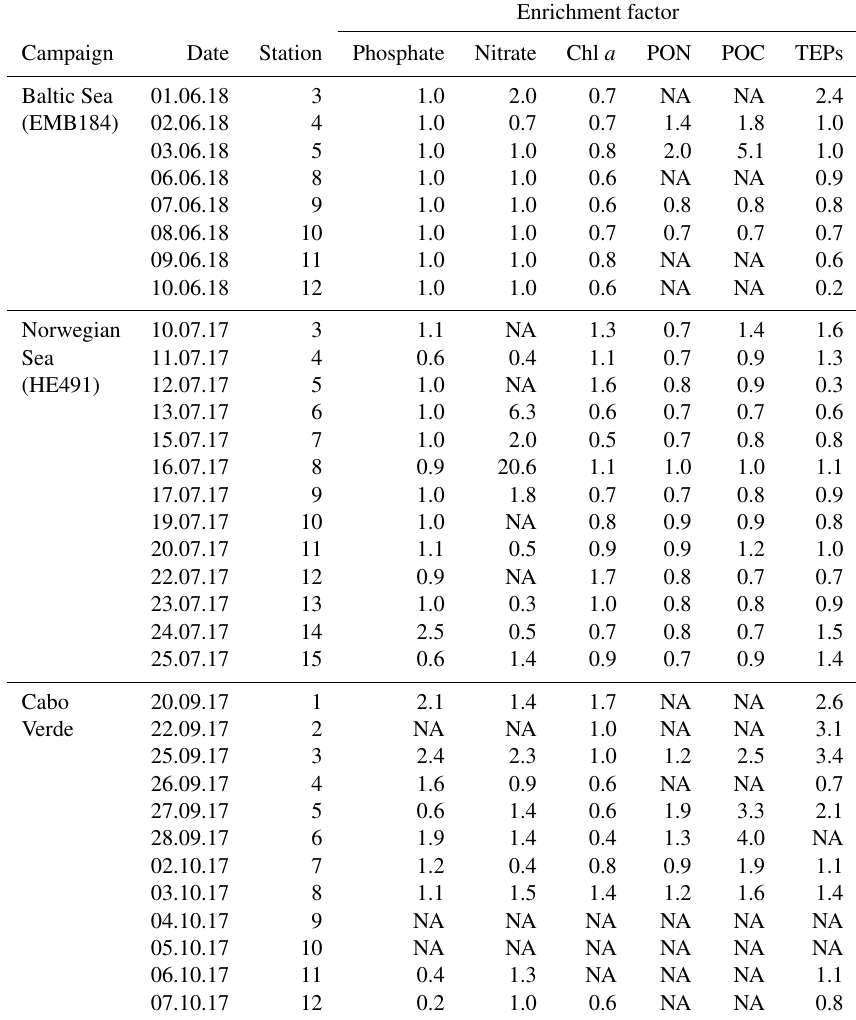
Table 2. Enrichment factors for each station. EF ≥ 1 shows enrichment in the SML. NA – not